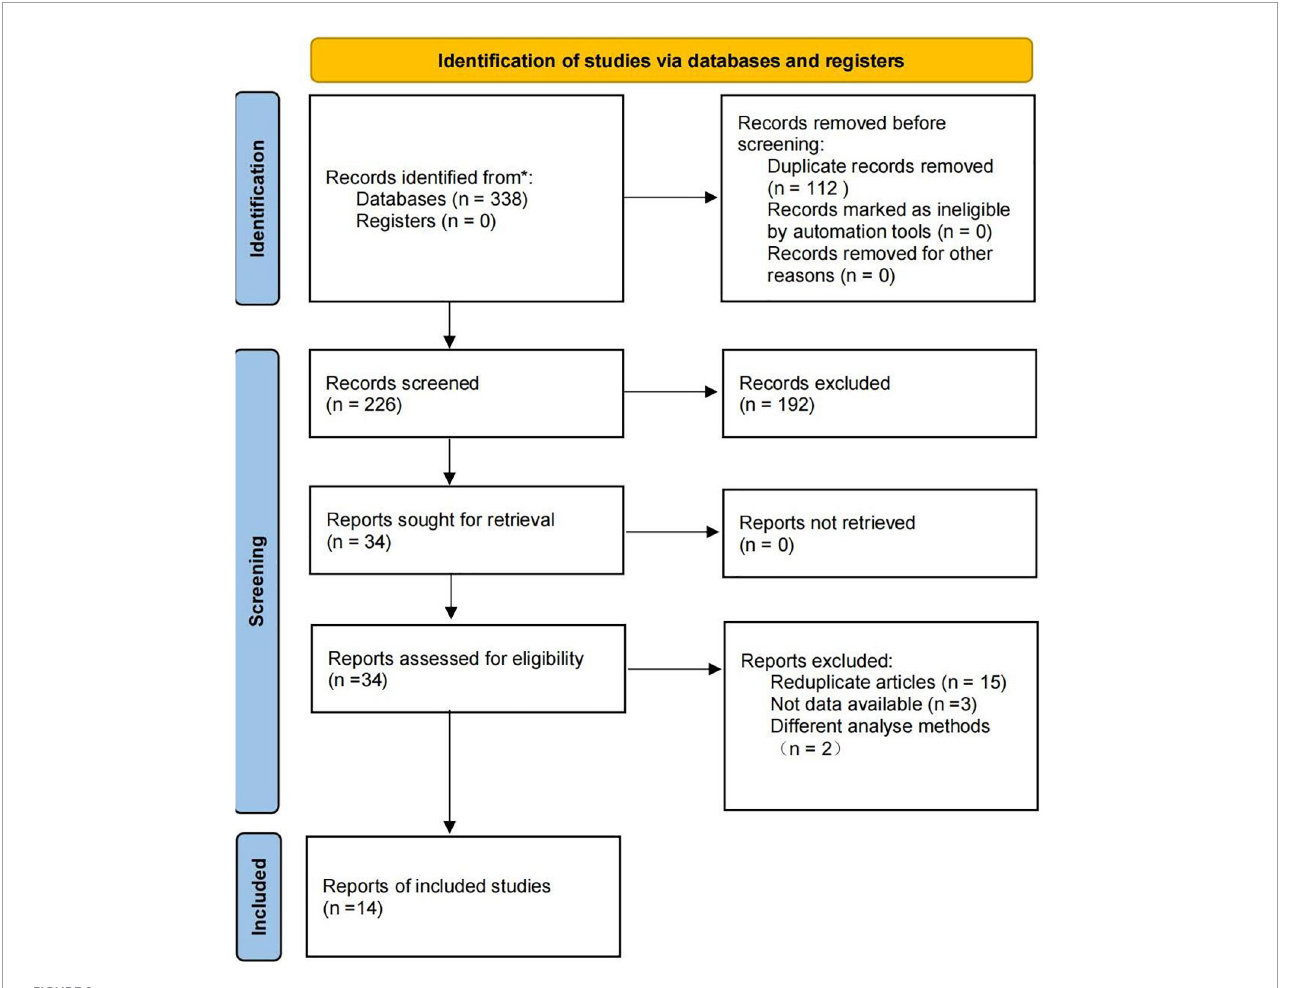
FIGURE2 Flow diagram of literature